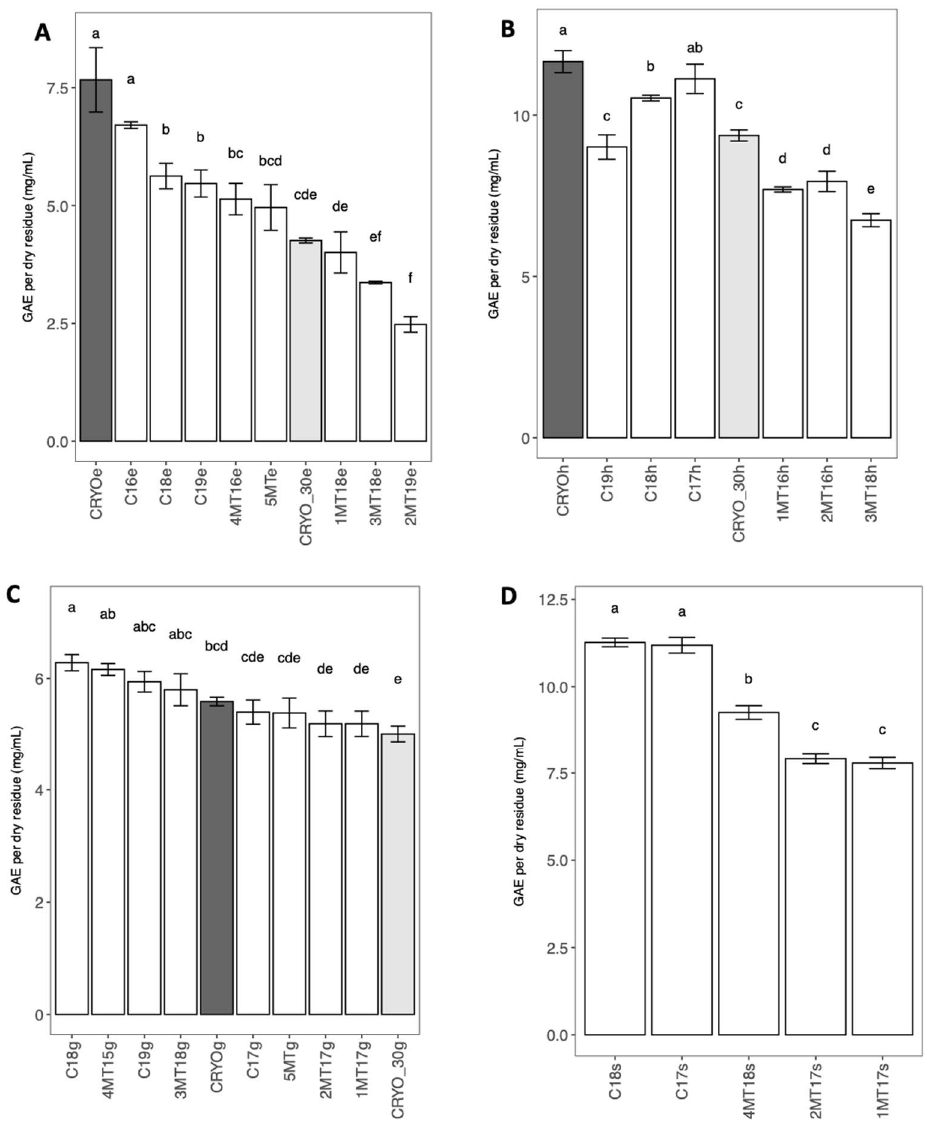
Figure 6. Comparison of scavenging effect obtained by means of potassium permanganate assay in the analyzed mother tinctures ( Echinacea purpurea ( A ), Hypericum perforatum ( B ), Ginkgo biloba ( C ) and Salvia officinalis ( D )) expressed as Gallic Acid equivalent (GAE) per dry residue (mg/mL). Different letters indicate the presence of significant differences between samples ( p ≤ 0.05).